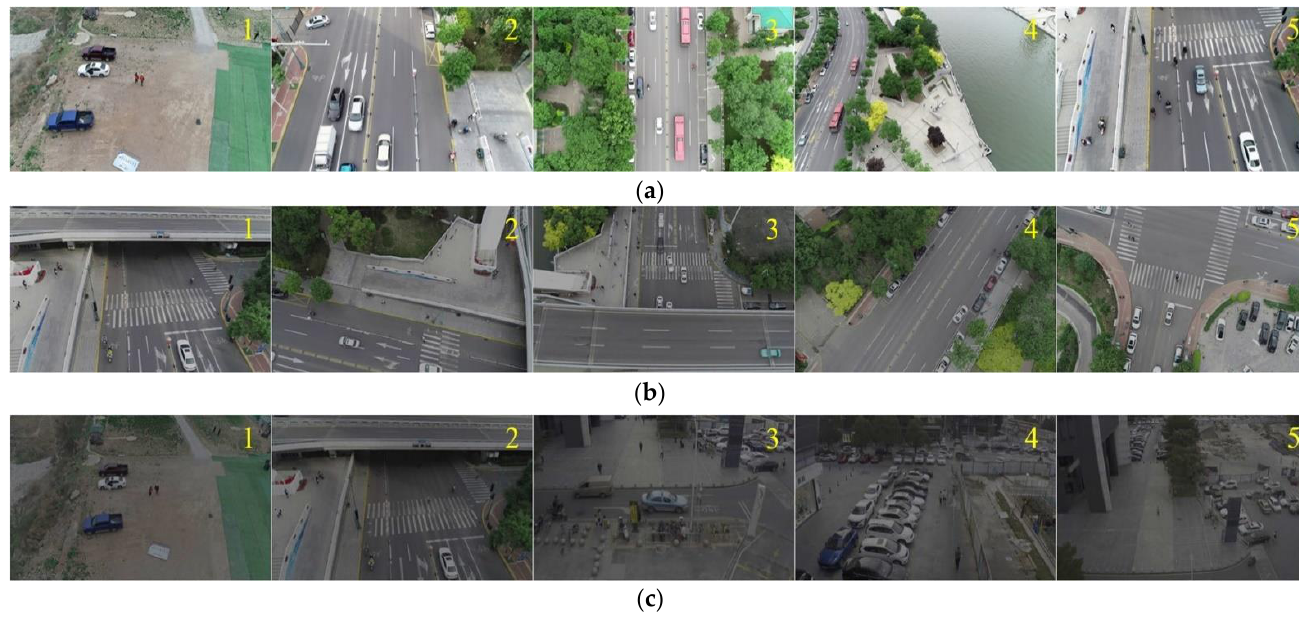
Figure 5. Image samples of environment luminance perception. ( a ) Images captured from excellent imaging luminance. ( b ) Images captured from ordinary imaging luminance. ( c ) Images captured from severe imaging luminance. Table 3. Accuracy comparison of different SVM construction methods.